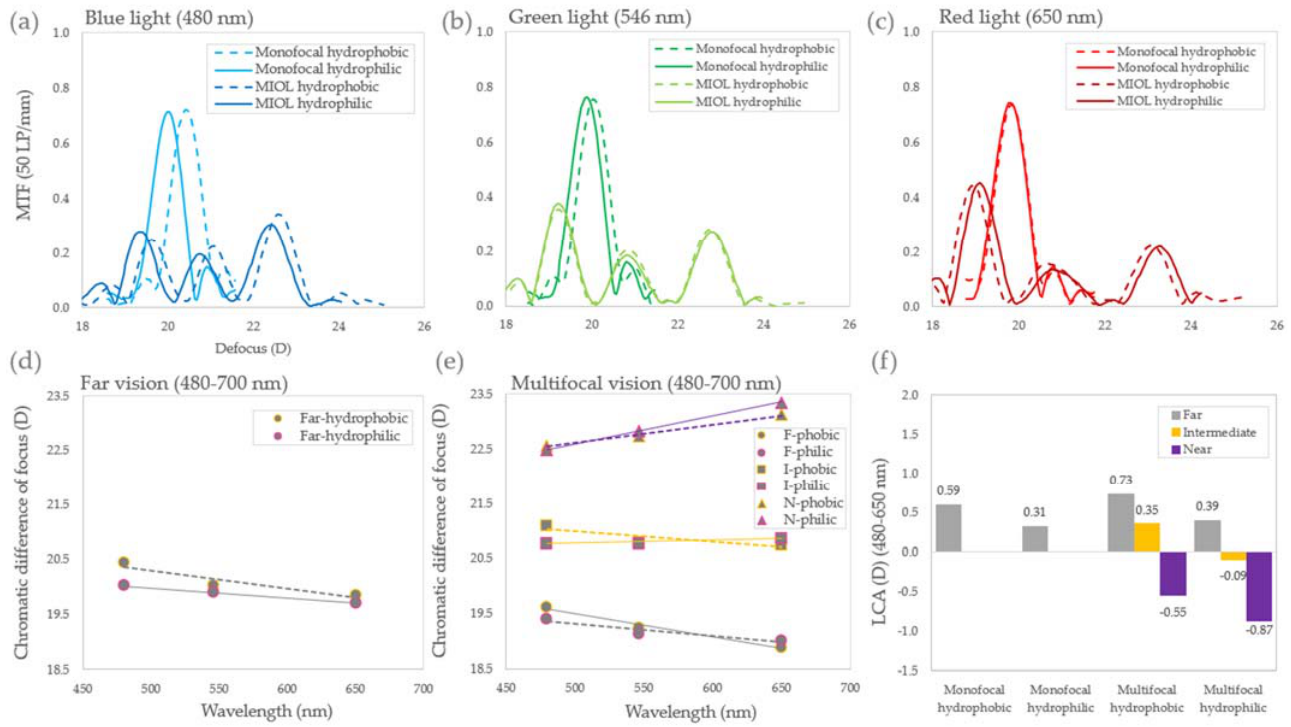
Figure 4. On-bench LCA. ( a – c ) TF MTF (50 LP/mm) for the monofocal, multifocal, hydrophobic (dashed lines), and hydrophilic (solid lines) for blue (480 nm), green (546 nm), and red (650 nm); ( d , e ) chromatic difference of focus (CDF) for the monofocal and multifocal IOLs, for far (gray lines), intermediate (yellow lines) and near (purple lines) distances; ( f ) longitudinal chromatic aberration (LCA) for the 480–650 spectral range for far (gray), intermediate (yellow), and near (purple) dis- tances.